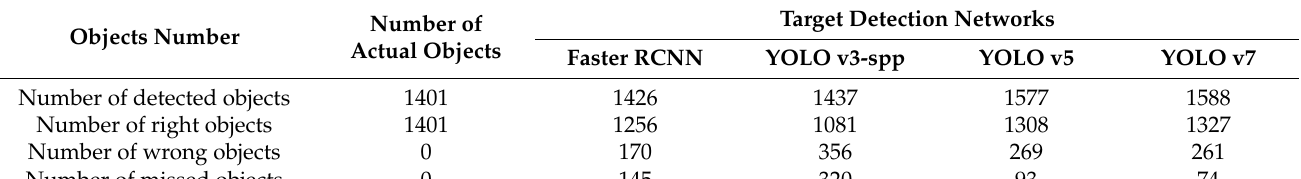
Table 2. Detection result of different models.